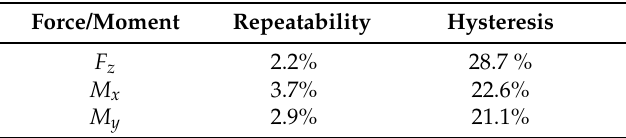
Table 3. Sensor Performance: Repeatability and Hysteresis.